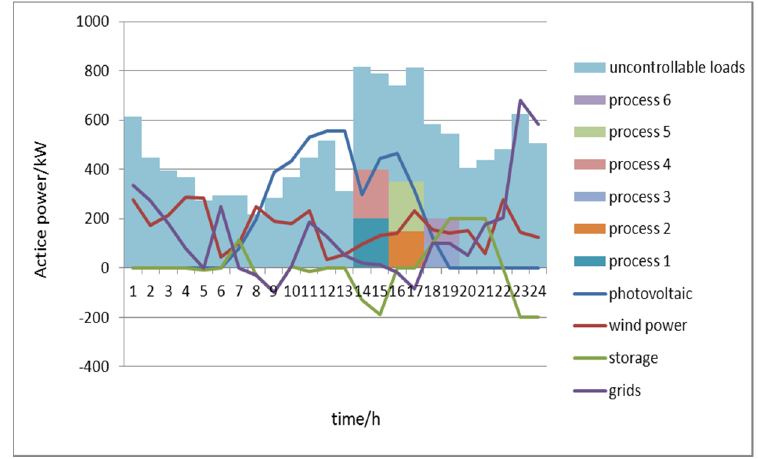
Figure 6. The process order and the power curve of the energy storage device after optimization.